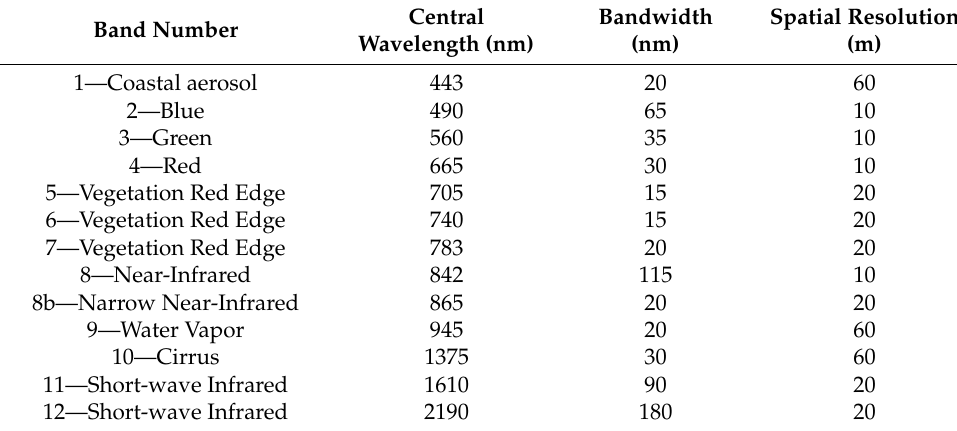
Table 1. Sentinel-2 band settings